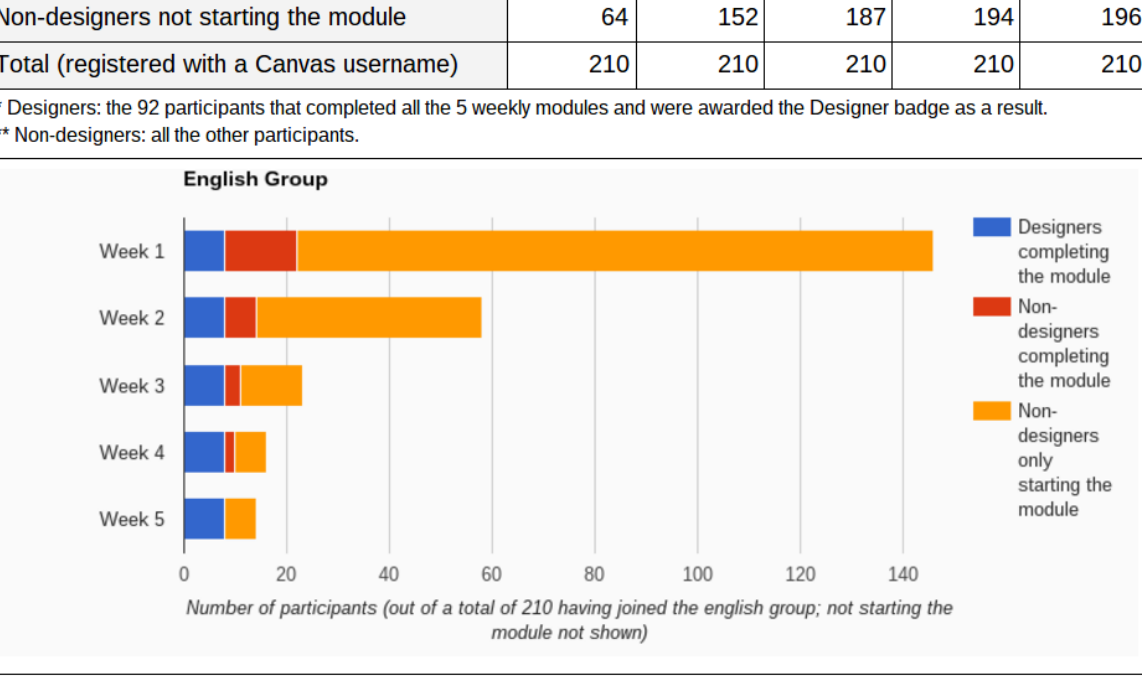
Figure 5 . English group: Participation in weekly modules of